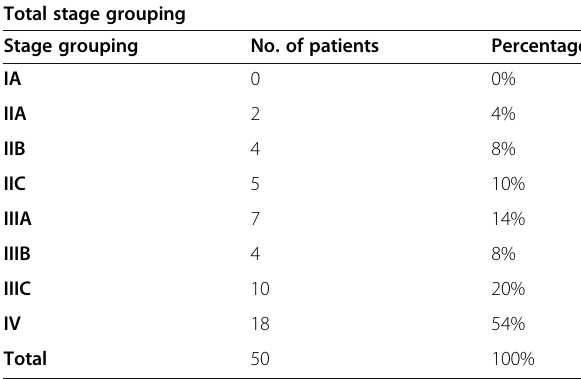
Table 1 The staging of patients with the TNM system and AJCC stage